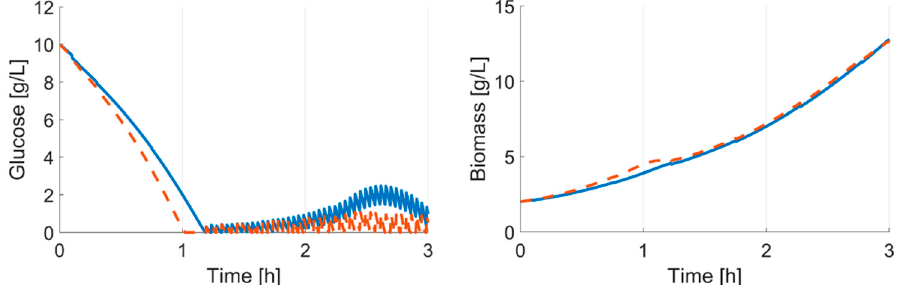
Figure 9. In-silico comparison of different clones; simulation based on last modelling cycle parameter set. Initial values: glucose 10 g L − 1 ; biomass 2 g L -1 . Solid line: E. coli BW25113; dashed line: E. coli BW25113 Δ gatZ . Feed start is simulated at 2.3 h; µ set is fixed at 0.5 h − 1 . If the feed start and rate are only adjusted to one strain, the cultivation of the Δ gatZ mutant would lead to overfeeding.